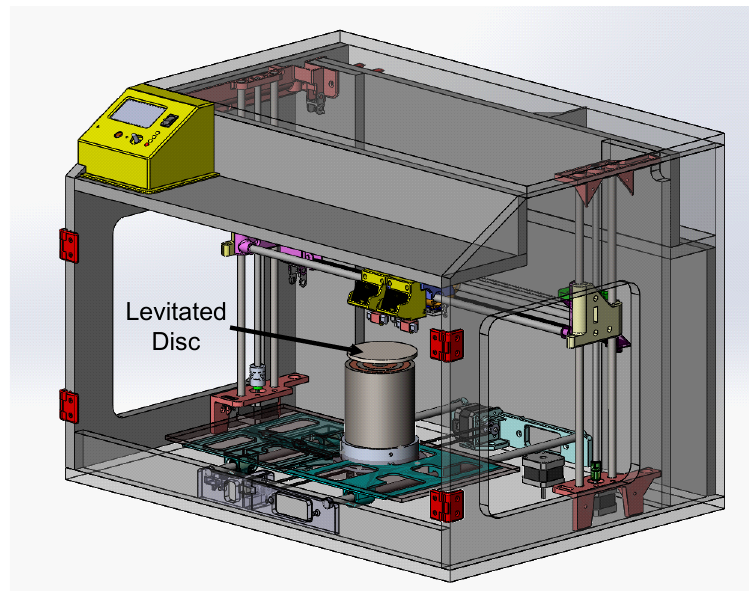
Figure 16. Envisioned MagLev system within the AM